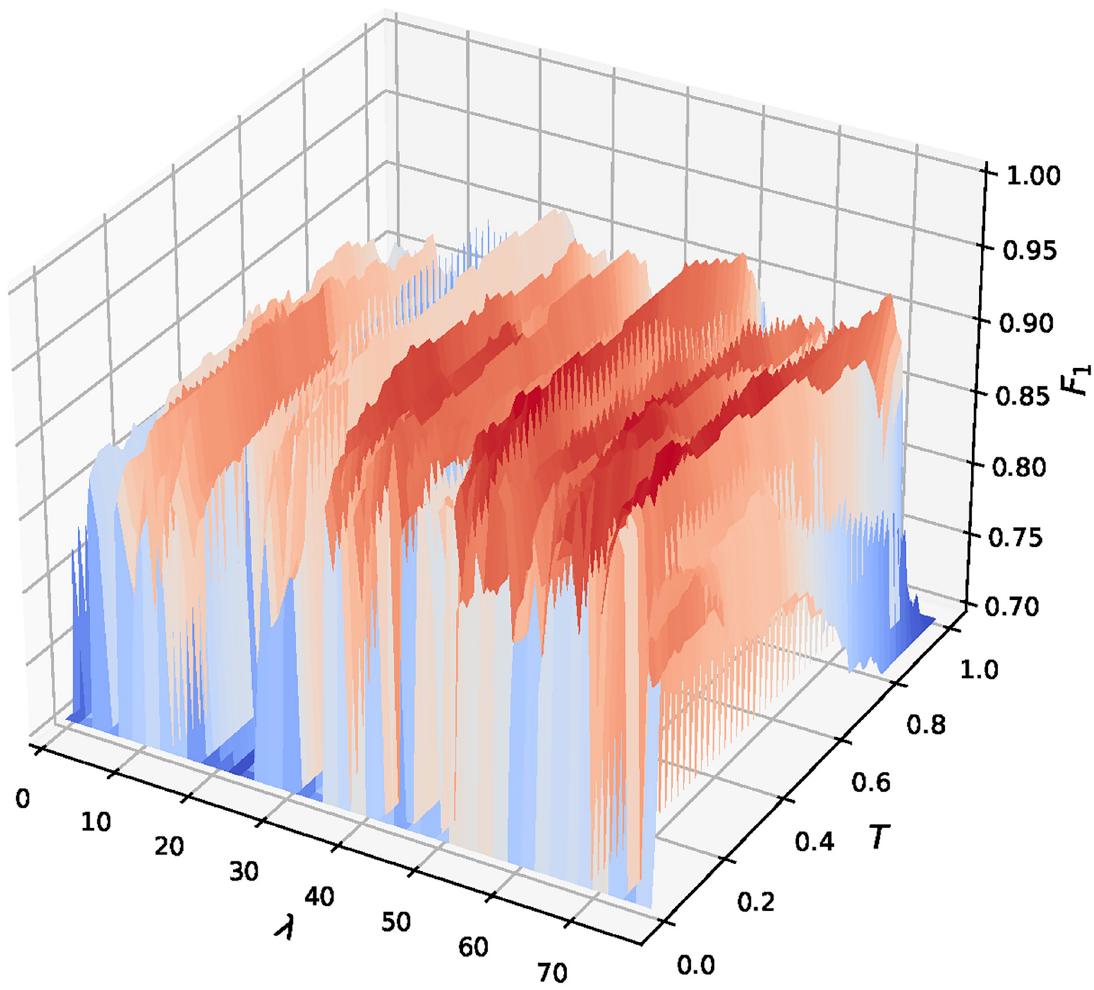
Fig 3. 3D plot of F 1 against ratio λ and threshold T